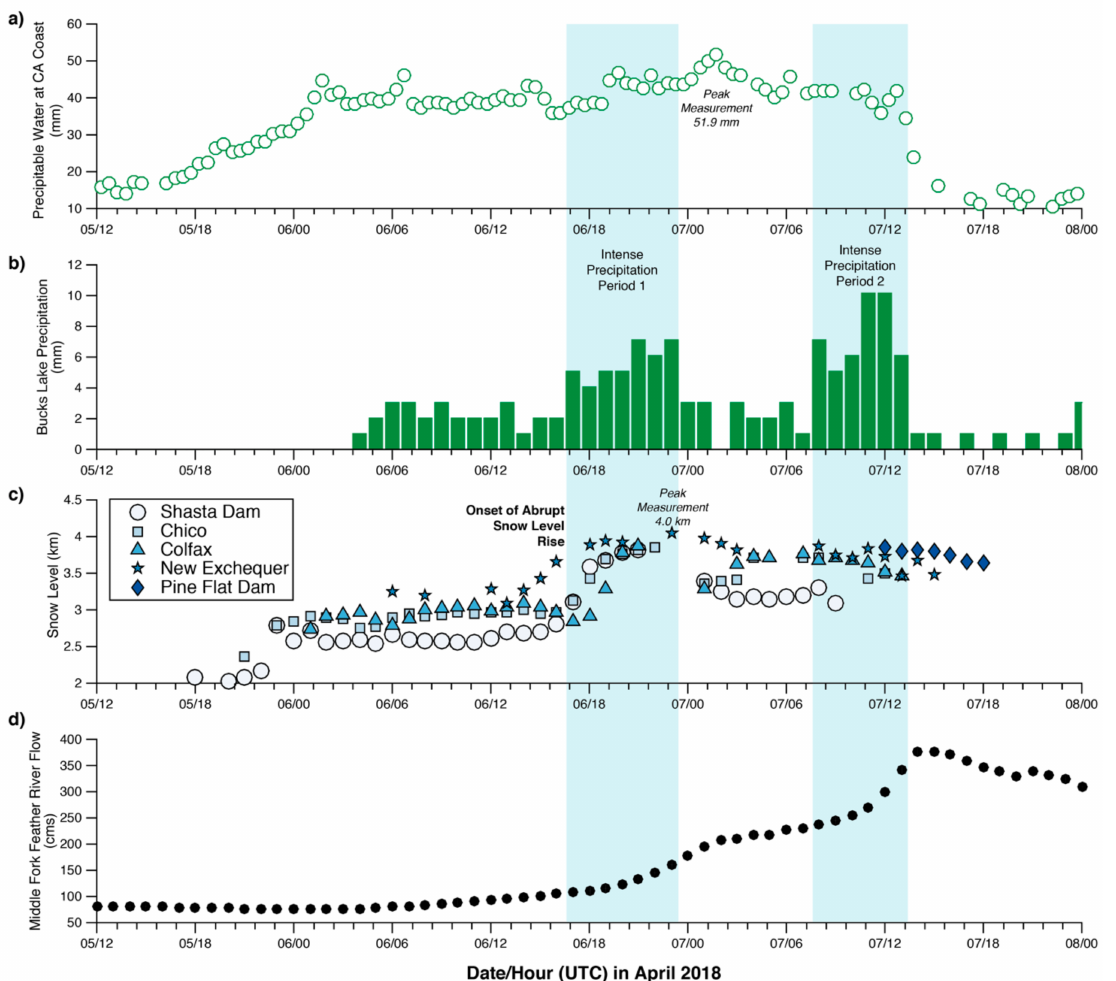
Figure 4. ( a ) Time series of precipitable water (mm) at the California (CA) coast near Half Moon Bay; ( b ) precipitation observations (mm) at Bucks Lake, California; ( c ) brightband-derived snow levels at five snow level radars upstream of the Sierra Nevada crest (km; ordered from north to south) and ( d ) observed streamflow (cms) on the Middle Fork of the Feather River. Vertical blue bars denote the two periods of intense